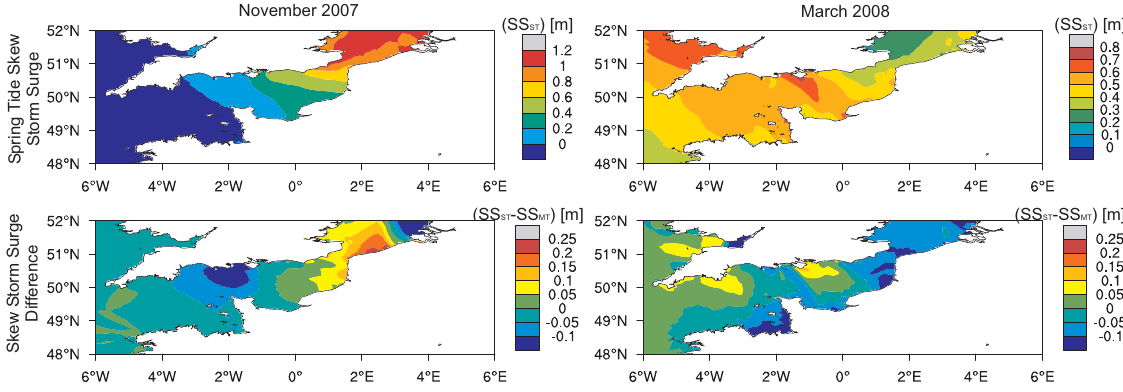
Fig. 8. High tide skew storm surges for mean spring tide (left) and the difference between skew storm surges obtained for a mean neap tide and a mean spring tide (right), for the November 2007 (above) and March 2008 (below) events. The meteorological forcing is the same as in Fig. 5. Data interval: 12 min.